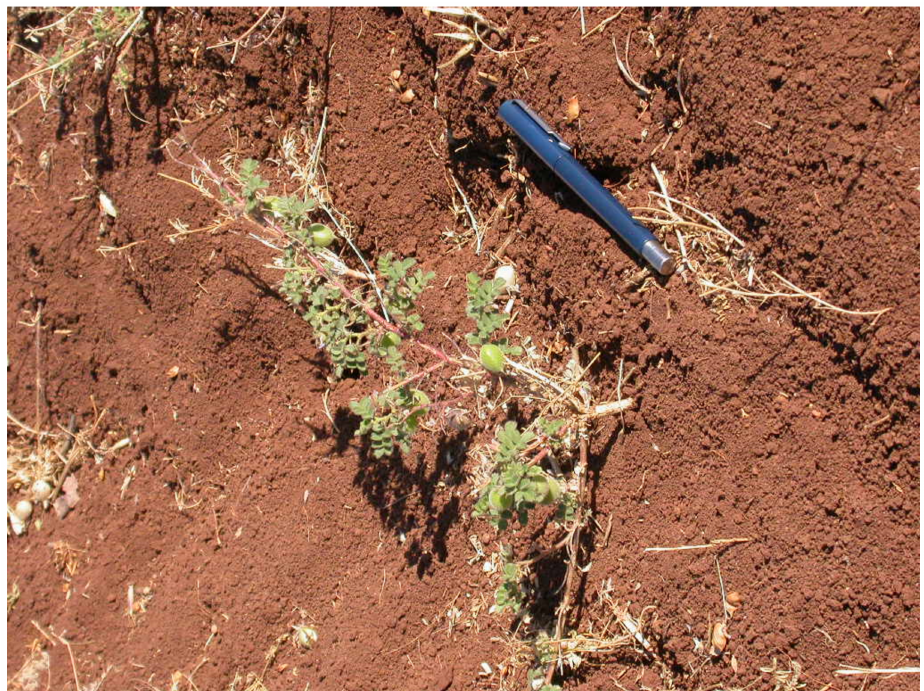
Figure 2. Wild C. echinospermum after mechanical mowing and swathing in a lentil field between Hilvan and Siverek, southeast Turkey, June 2003 (photo by S. Abbo).